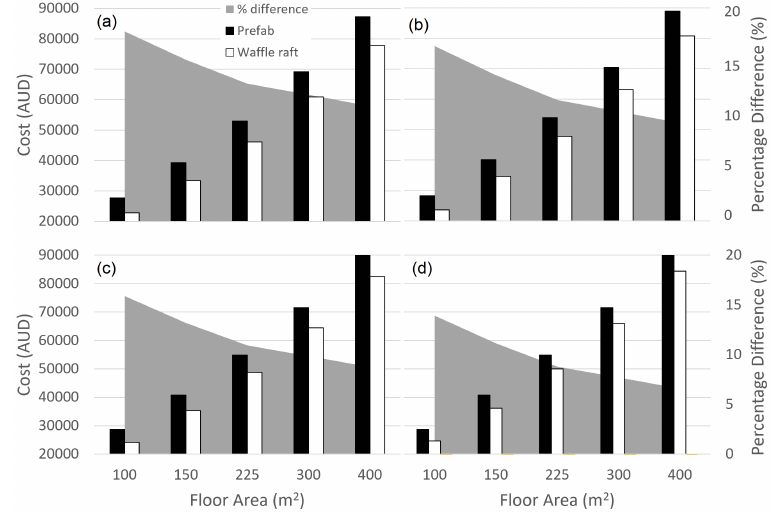
Figure 8. Comparison of the Life Cycle Cost analysis between the prefabricated system and waffle raftsfor each site classification, ( a ) Class M/M-D, ( b ) Class H 1 /H 1 -D, ( c ) Class H 2 , and ( d ) Class H 2 -D. Table 8. Material quantity survey of the developed prefabricated footings systems and the monolithic waffle rafts. Prefabricated Footings Waffle Rafts M/M-D Section